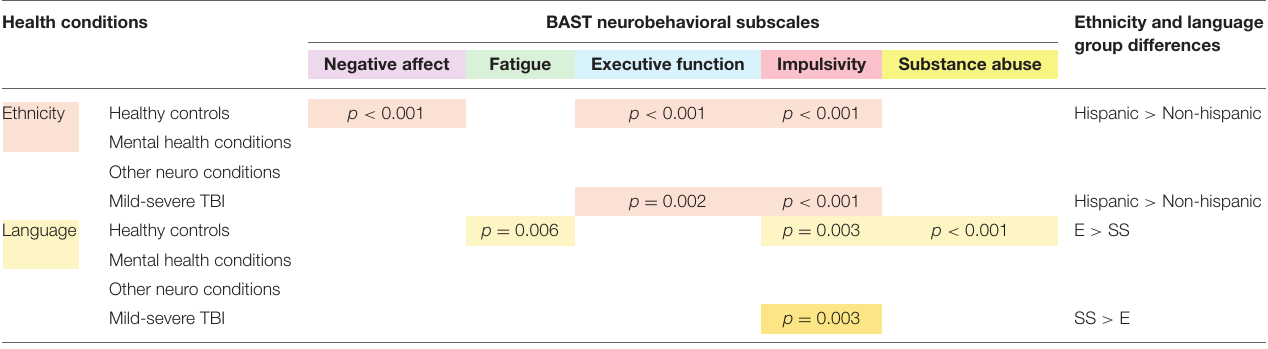
TABLE 7 | Exploratory group comparisons of ethnicity and language by health condition in a national cohort of